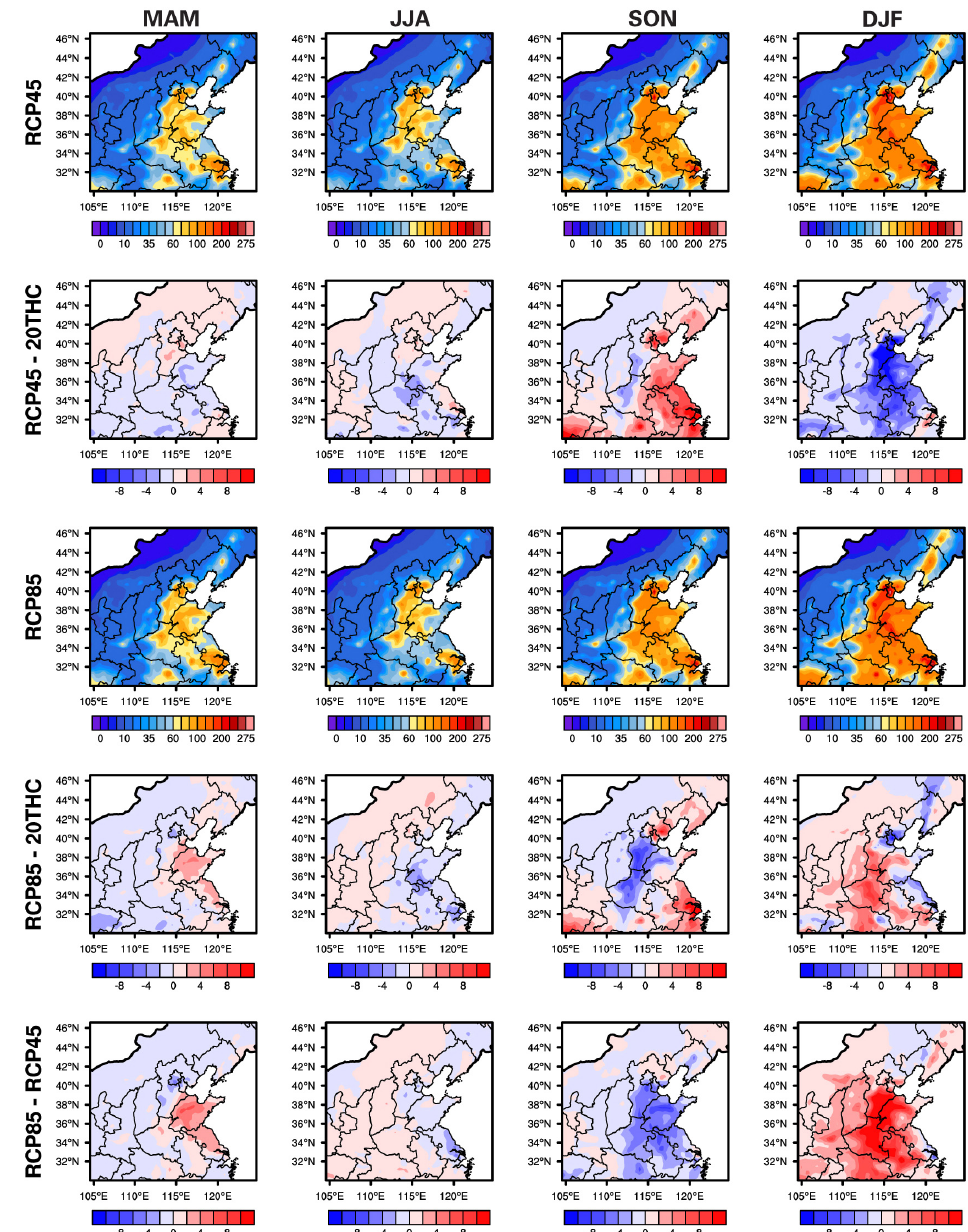
Figure 7. The same as Figure 6 but for the surface concentration of PM2.5.